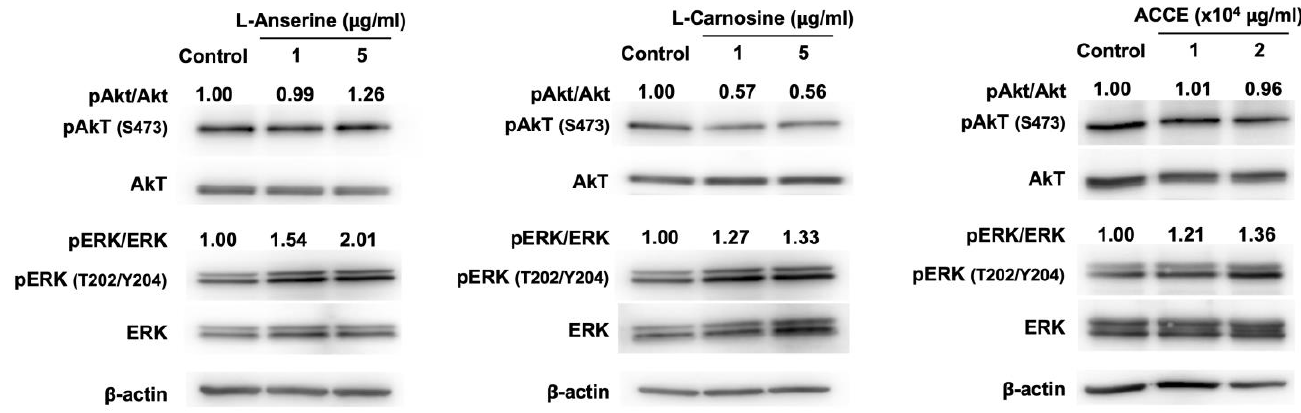
Figure 5. Effect of L-anserine, L-carnosine, and ACCE on melanogenesis-related signaling pathway. Western blot analysis was performed to determine the ratio of phosphorylated and non-phosphorylated Akt and ERK in MNT-1 cells at 24 h.